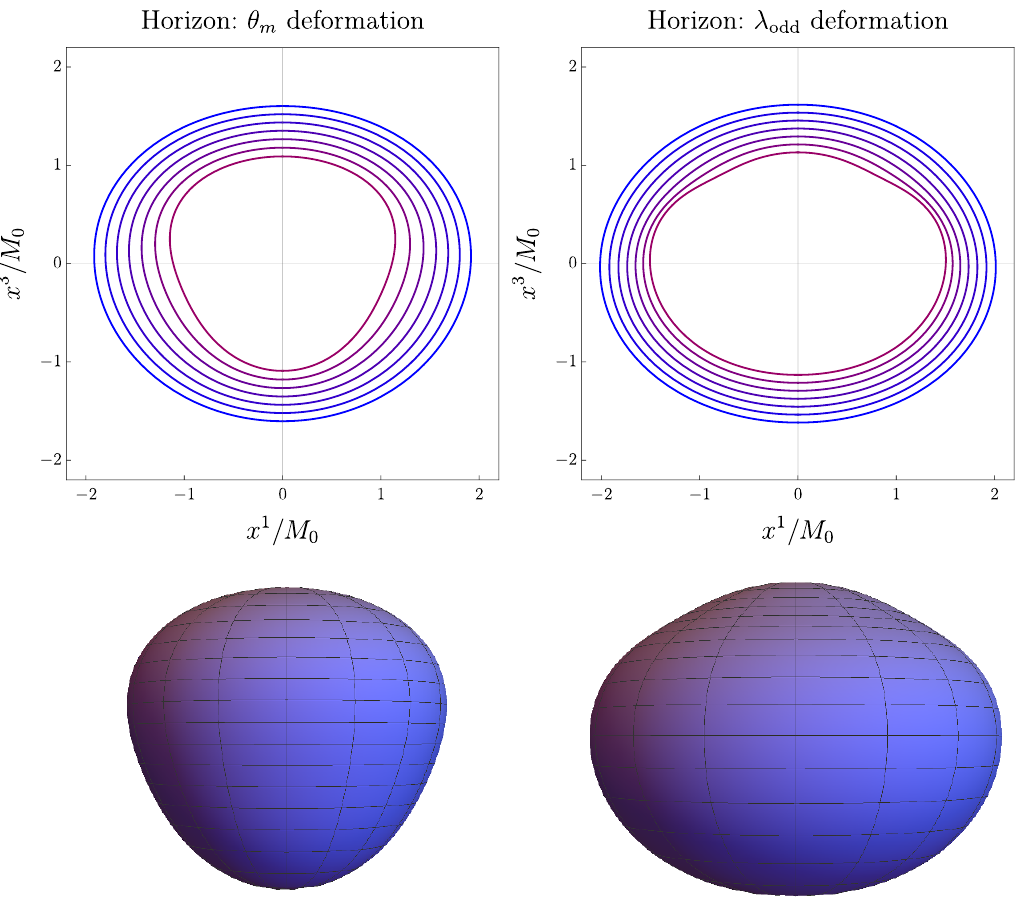
Figure 5 . Isometric embedding of the horizon in E 3 for parity-breaking theories. For clarity reasons we do not include the comparison with Kerr solution. In the top row we plot the horizon for di(cid:11)erent masses ( M 0 (cid:21) M (cid:21) 0 : 7 M 0 for some reference mass M 0 ) while keeping (cid:31) = 0 : 65 and the couplings constant. In each case, only the indicated couplings are non-vanishing. Left: (cid:11) 1 = (cid:11) 2 , p (cid:18) m = (cid:25)= 2, M 0 (cid:25) 2 : 23 ‘ j (cid:11) 1 j . Right: (cid:21) odd > 0, M 0 (cid:25) 1 : 46 ‘(cid:21) 1 = 4 the horizon for ‘ 4 (cid:11) 2 = ‘ 4 (cid:11) 2 = 0 : 15, (cid:18) m = (cid:25)= 2 (left) and for ‘ 4 1 2 M 4 M 4 the Z 2 symmetry is manifestly